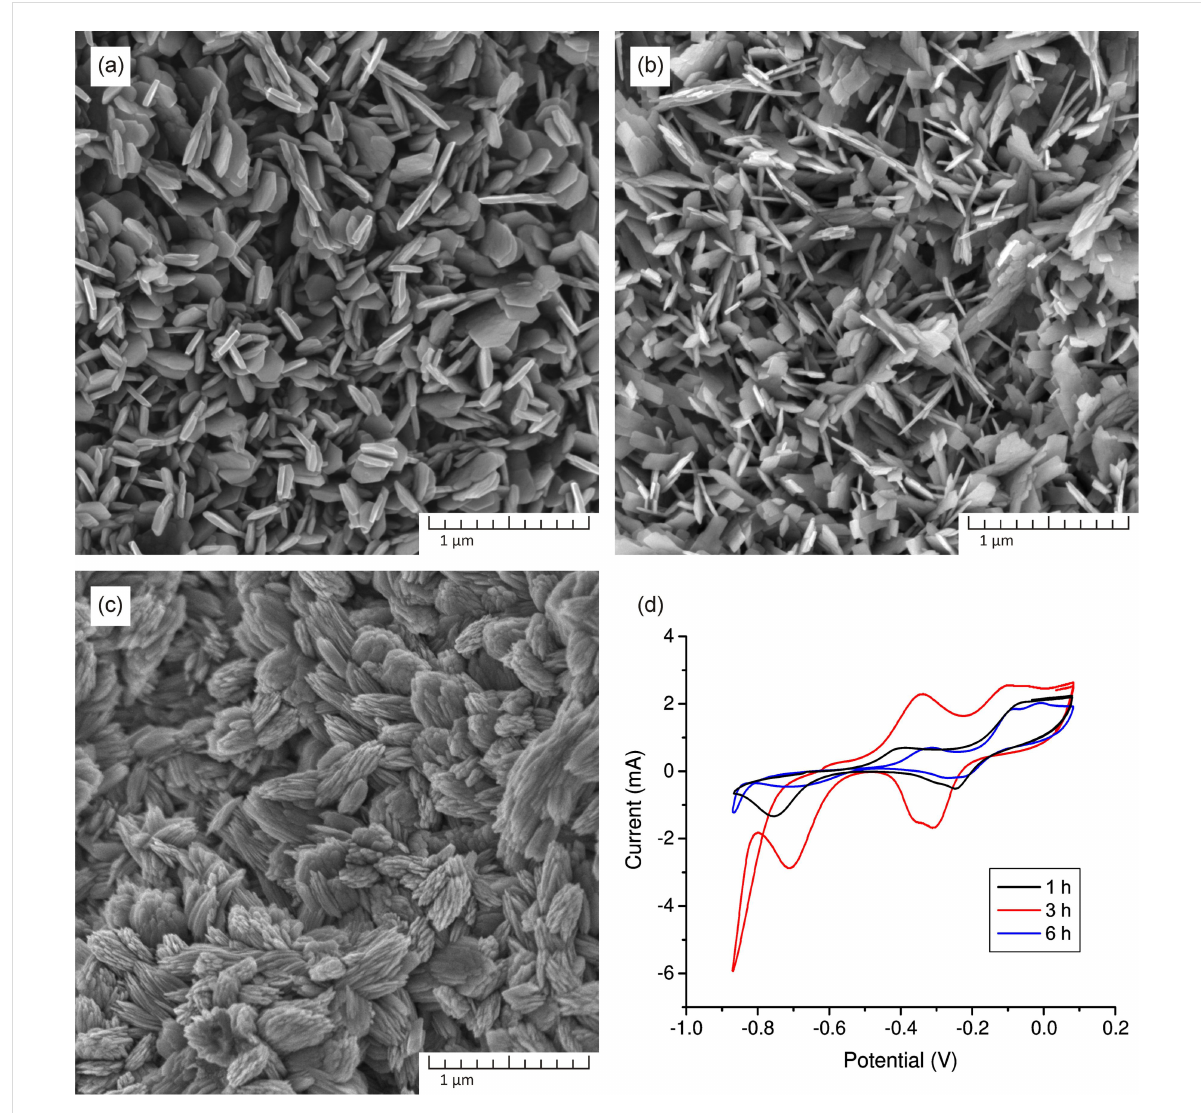
Figure 4: SEM images of CuO nanostructures obtained via hydrothermal oxidation method after (a) 1 h, (b) 3 h, and (c) 6 h. (d) CV curves of the CuO samples after 1, 3, and 6 h of synthesis time. Measurements were carried out in 0.1 M NaOH solution containing 1 mM H 2 O 2 .